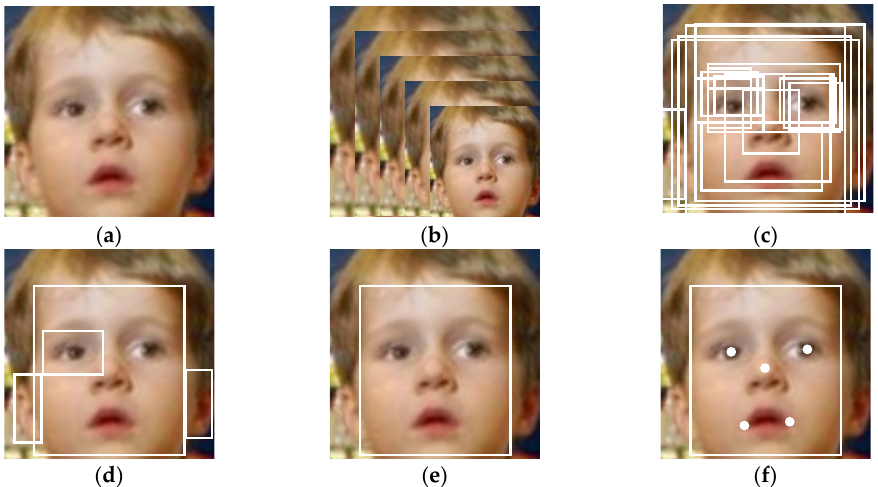
Figure 4. The process of face recognition and face alignment. ( a ) Clean image of a child. ( b ) Image pyramid. ( c ) Bounding box regression. ( d ) Merging the candidate objects. ( e ) Face location. ( f ) Key point location.